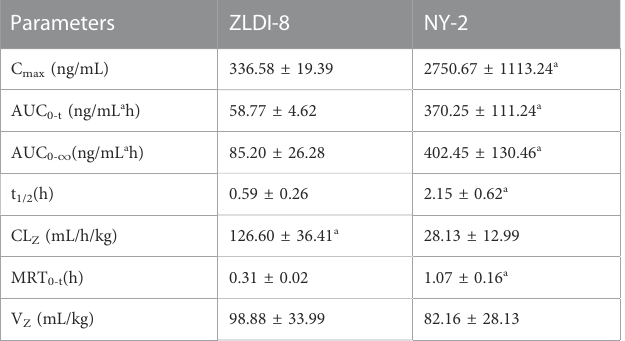
TABLE 2 Main pharmacokinetics parameters of compounds, ZLDI-8 and NY-2 in vivo. Parameters